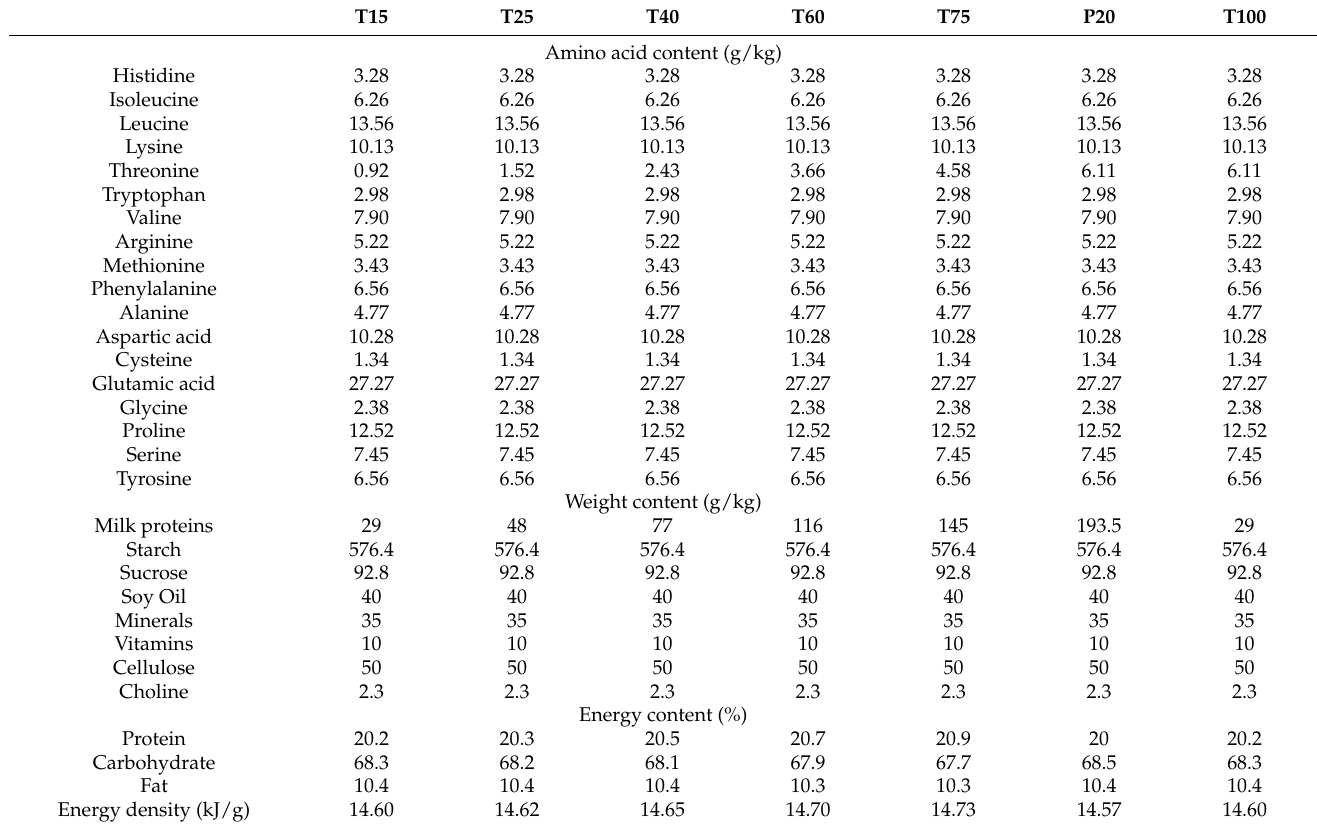
Table A2. Composition of experimental diets used to assess threonine